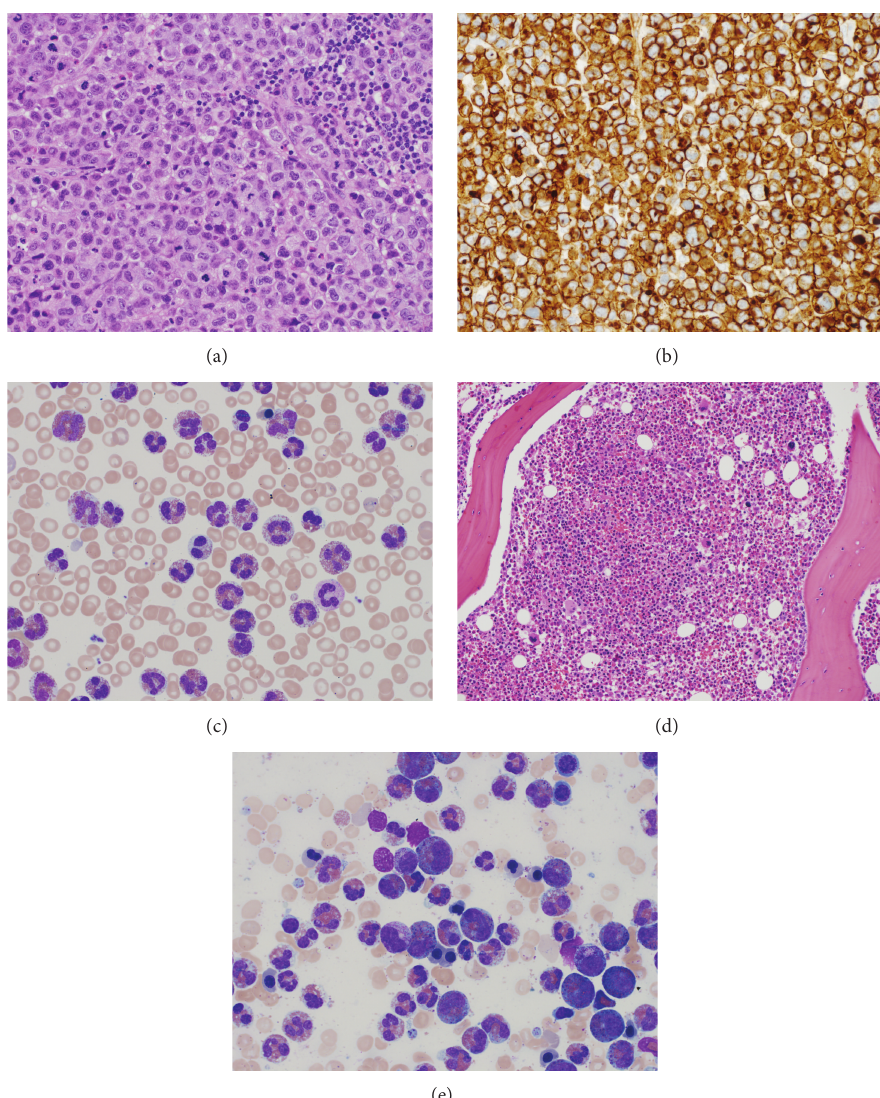
Figure1:(a)Excisionalbiopsyofcervicallymphnodeshowingsheetsoflargeatypicallymphoidcellswithfrequentmitoses.(b)PositiveCD30 staining of the lymphoma cells in the cervical lymph node biopsy. (c) Peripheral blood smear showing eosinophilia with partial degranulation and hypersegmentation. (d) Bone marrow core biopsy showing hypercellular marrow with markedly increased eosinophil precursors and eosinophils. (e) Bone marrow aspirate showing increased eosinophilic precursors, eosinophils with morphology similar to peripheral blood eosinophils and background